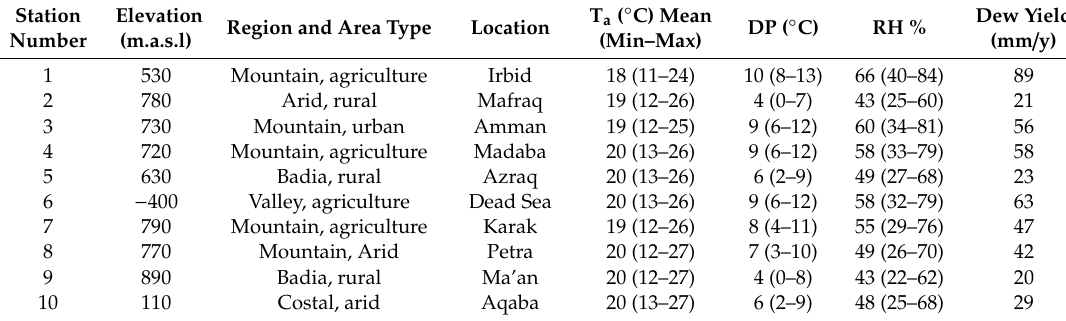
Figure 1. A map of Jordan illustrating the geographical topography and the selected location, where the model simulation was performed. See also Table 1 for locations characteristics. Table 1. Selected locations and their geographical and environmental characteristics.